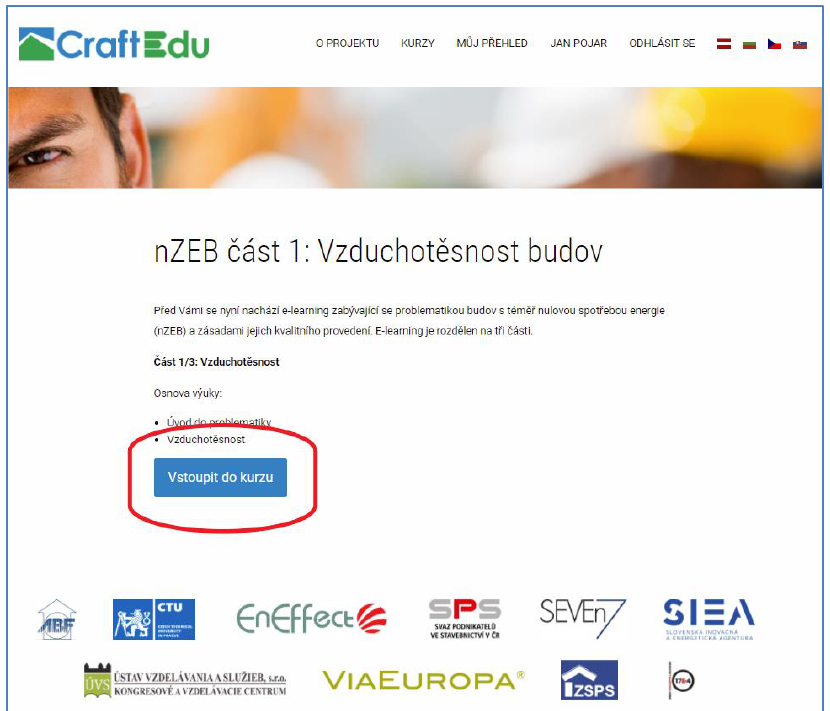
Figure 2: E-learning course introduction page – Airtightness – for the Czech variant (source: authors)